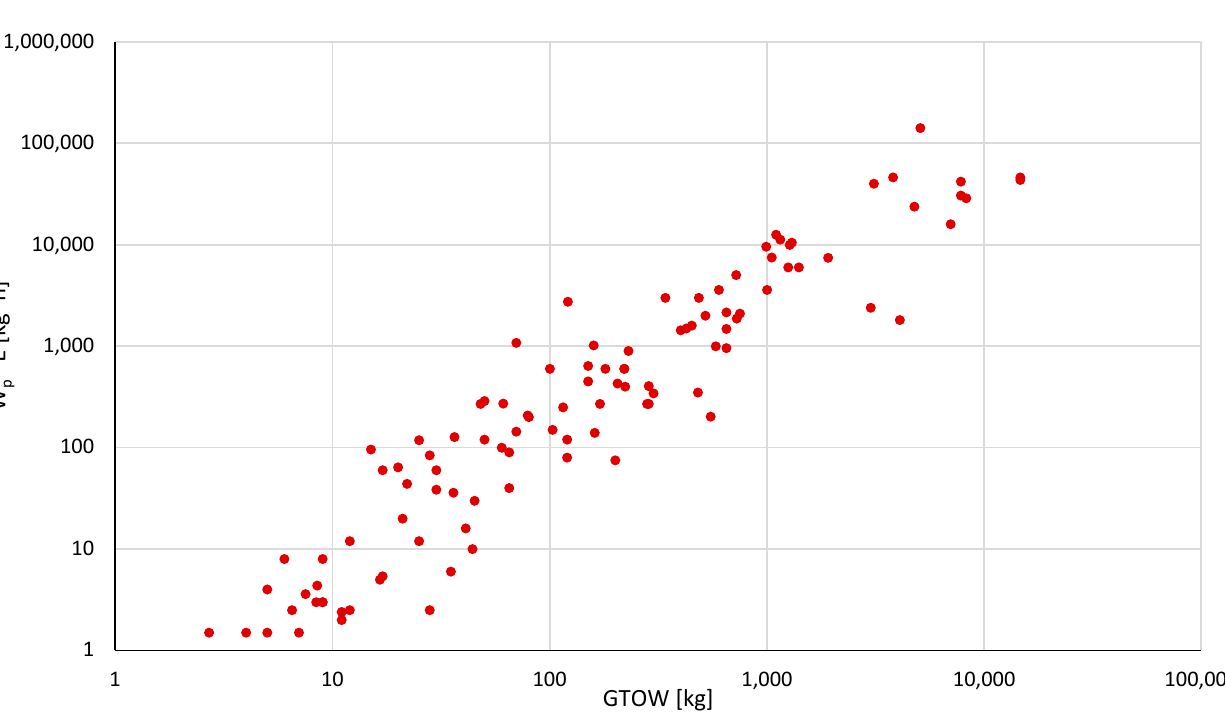
Figure 18. W p · E as a function of GTOW with respect to NATO categories.